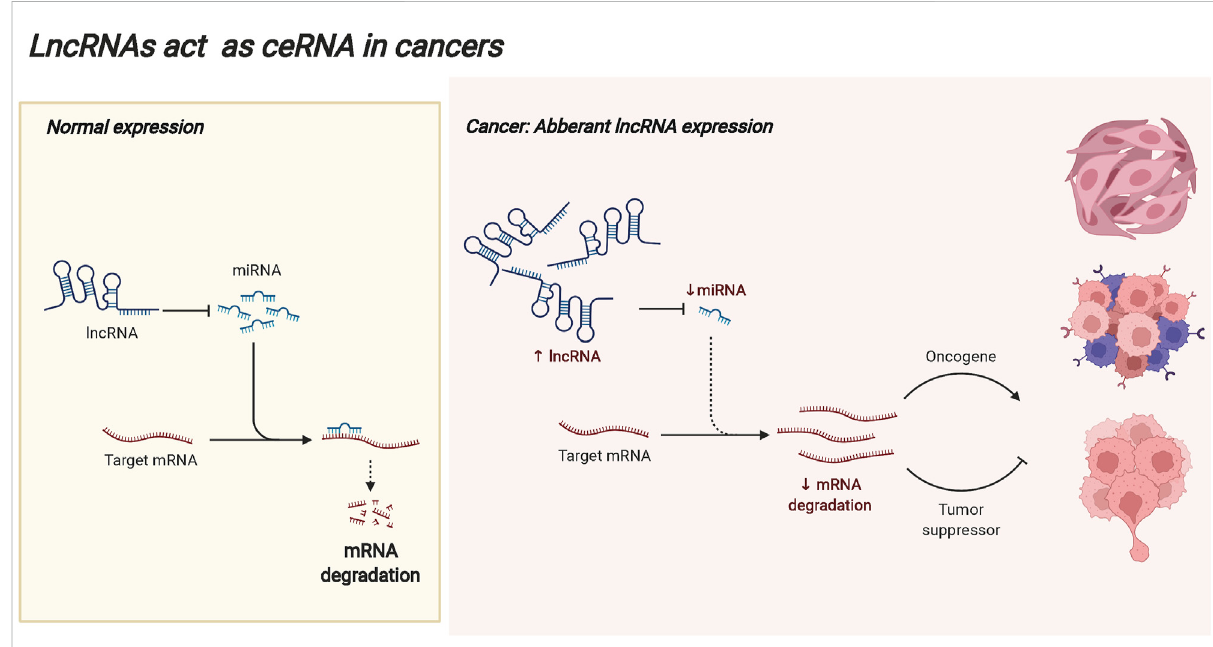
FIGURE 3 The ceRNA mechanism of lncRNAs. In the cytoplasm, lncRNAs can act as competing endogenous RNAs (ceRNAs) to compete with miRNAs for binding and contribute to the release of target mRNAs. In the occurrence and progression of tumors, abnormally expressed lncRNAs may break this balance, resulting in the abnormal expression of tumor-promoting genes or tumor suppressor genes, and promoting the malignant progression of